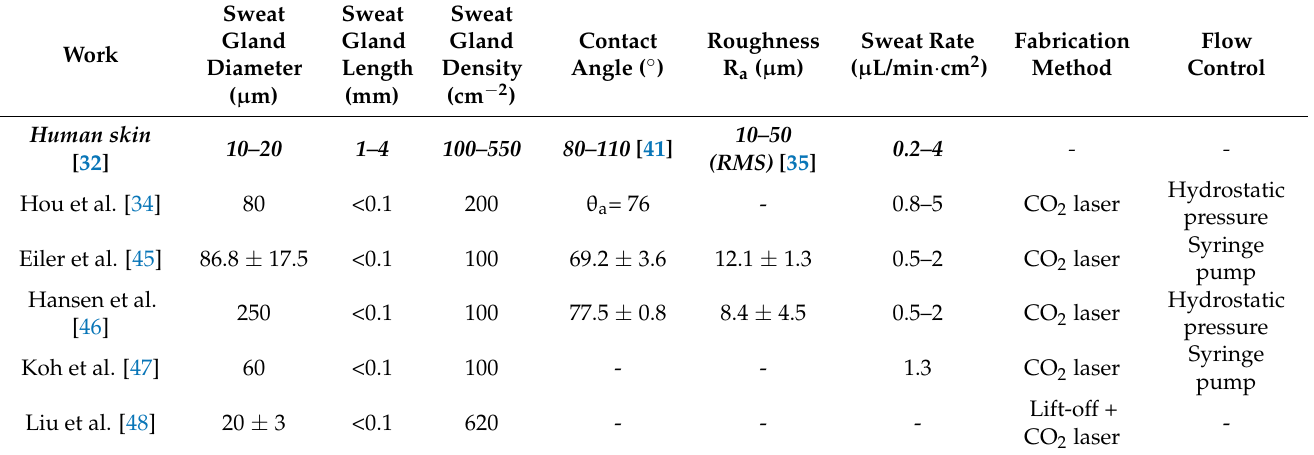
Table 1. Comparison of the key parameters of laser-machined perspiration models found in the literature with respect to human skin